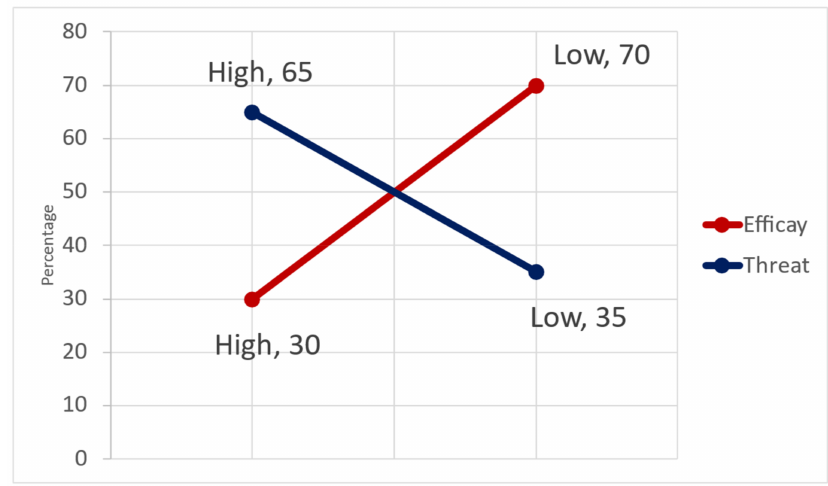
Figure 10. Attitude on disaster